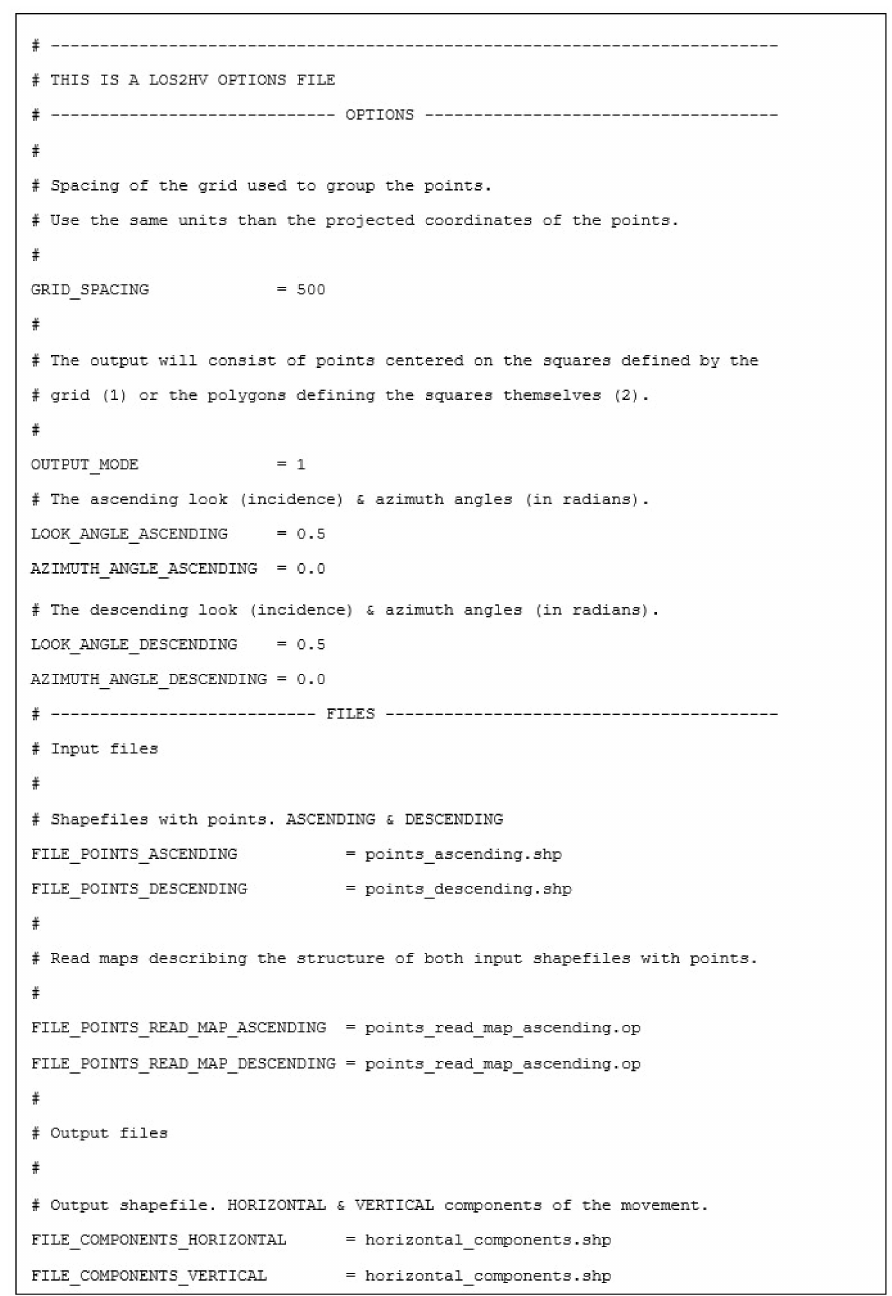
Figure 10. A real example of a los2hv options file.